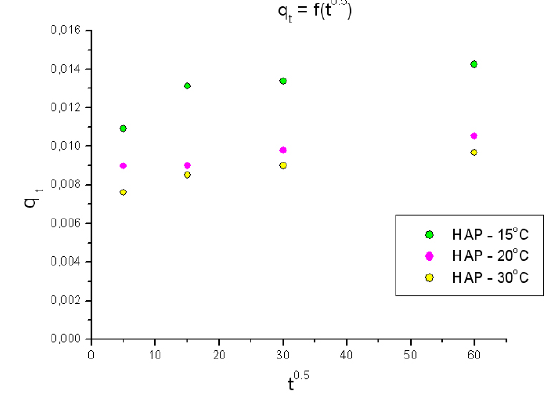
Figure 8. The applicability of intraparticle diffusion model to nicotinic acid adsorption on hydroxyapatite Table